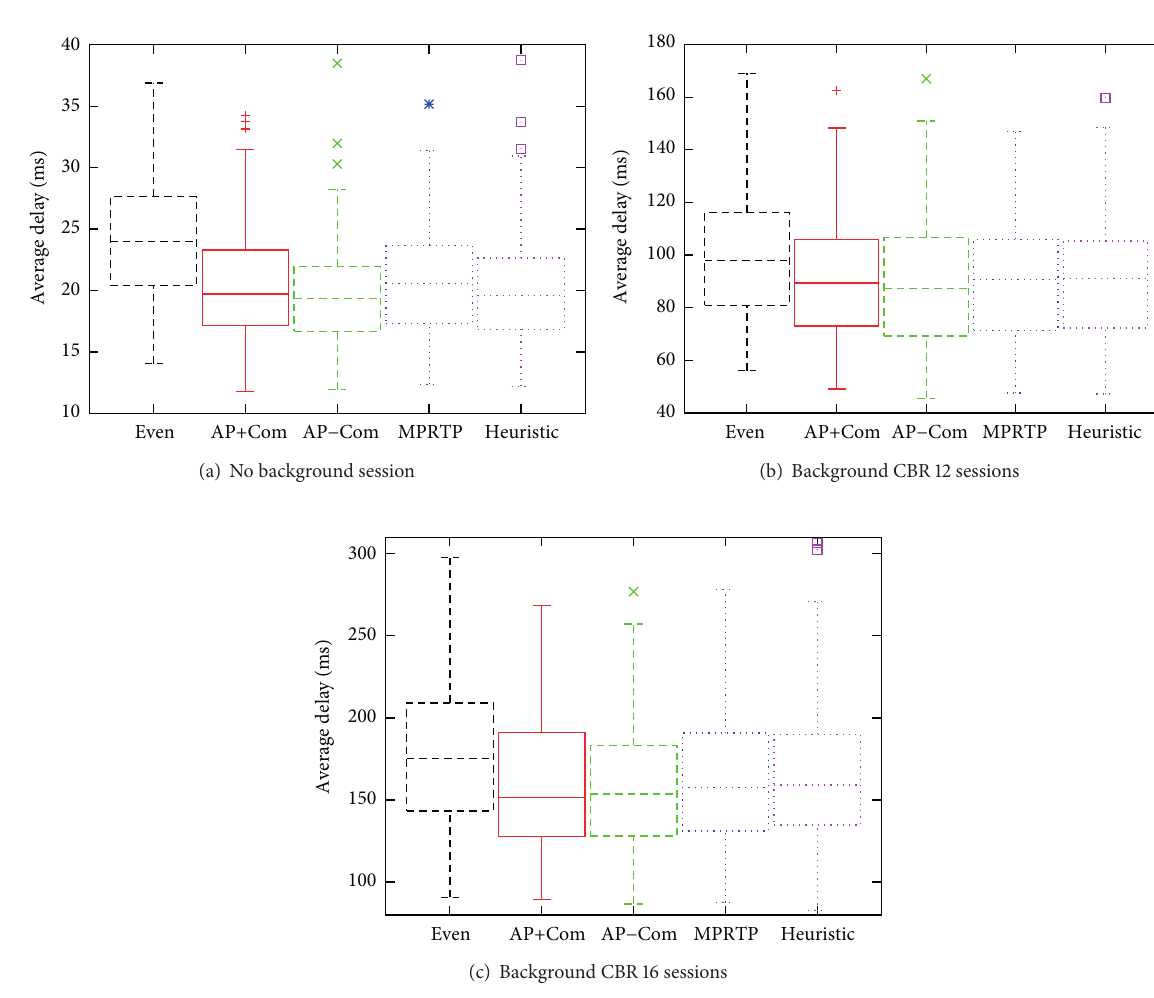
Figure 6: Average delay comparison under mobility scenario ( 𝑦 -axis is capped for